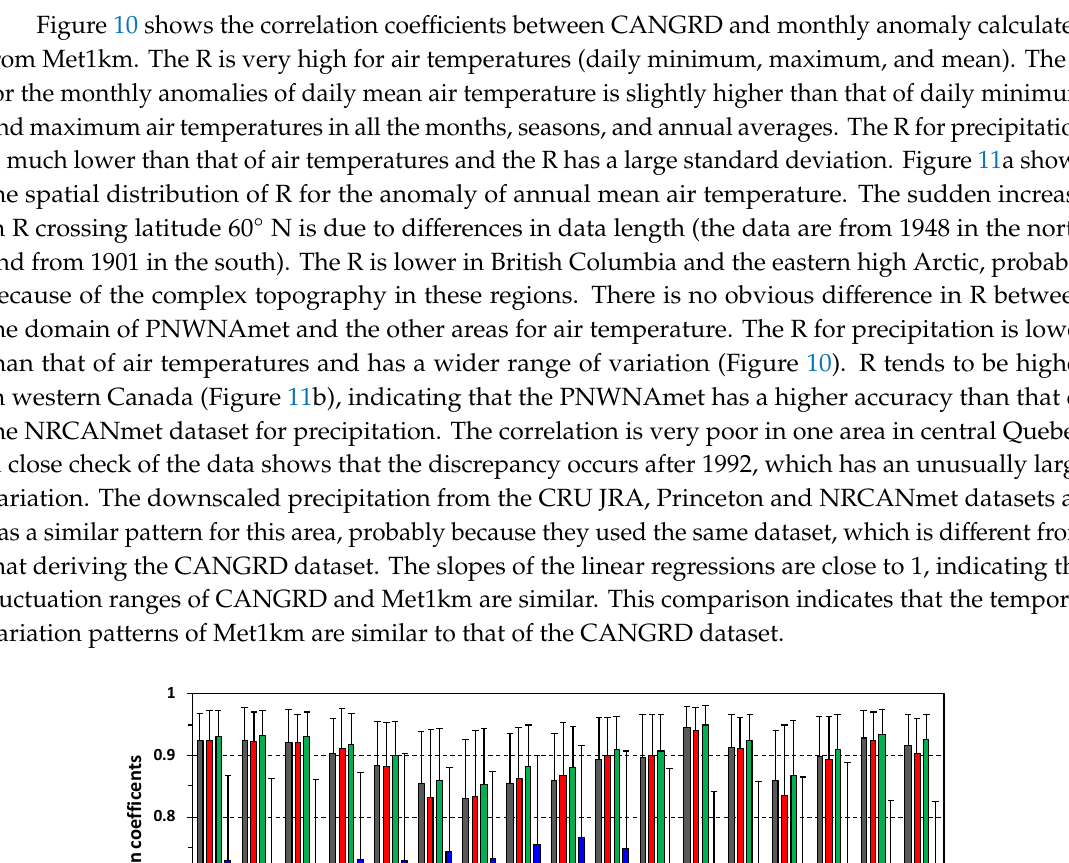
0.50.60.70.80.91 Figure 10. Correlation coefficients between the monthly anomalies of Met1km and the CANGRD dataset. The daily data from Met1km were converted to monthly anomalies corresponding to the grids of the CANGRD dataset. The large bars and the error bars are the averages and standard deviations of the 4890 grids of the CANGRD dataset. Figure 11. Correlation coefficients between the CANGRD and the anomalies of Met1km datasets for ( a ) annual mean air temperature and ( b ) annual total precipitation. The daily data from Met1km were converted to anomalies corresponding to the CANGRD dataset. The data were from 1901 in southern Canada (south of 60 °N) and from 1948 in northern Canada. 4.6. Comparing the Accuracy of Met1km and the Source Datasets Figure 12 shows the errors of Met1km and the source datasets and the effects of downscaling by comparing with the second generation homogenized daily air temperature and precipitation dataset [43]. The errors of the source datasets were calculated by directly comparing the grid values with the station data. The downscaling effects on the errors were calculated by comparing the station data with the source data downscaled to 1-km resolution using the re-baselining method. For the CRU JRA and the Princeton datasets, spatial downscaling reduced the mean error (absolute value of the error in long-term average) by about a half for daily mean, minimum, and maximum air